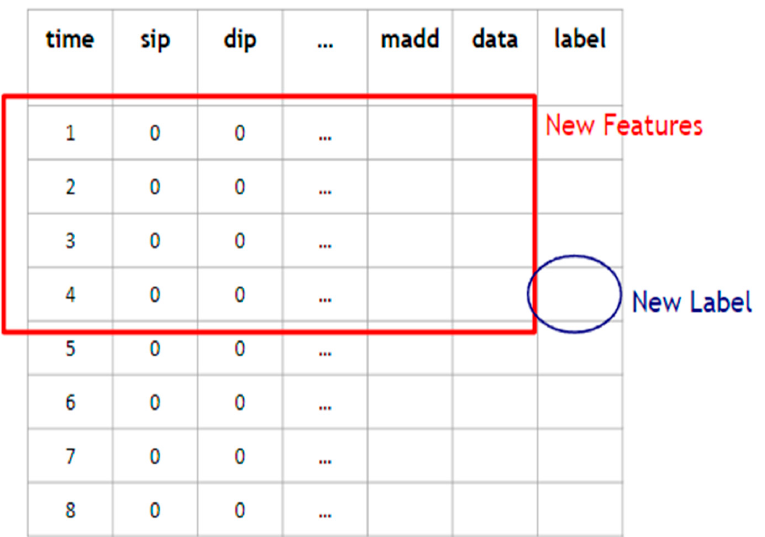
Figure 8. New features and a label are derived from a sliding window of s = 4 consecutive packets of a